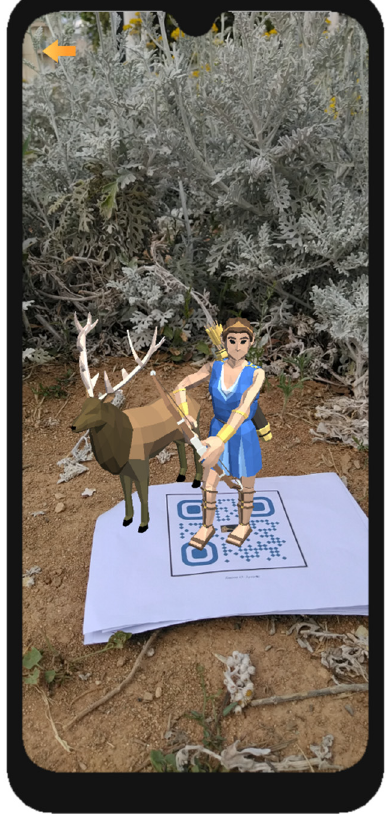
Figure 4. AR preview of the goddess Artemis.